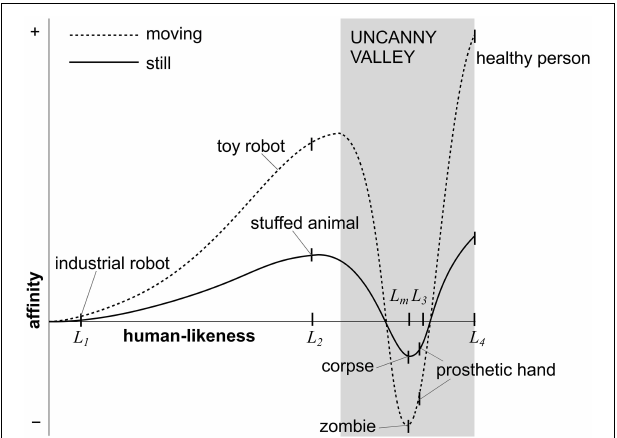
FIGURE 1 | Mori’s uncanny valley curve demonstrating the non-linear relationship between the human-likeness of stimuli (clearly artificial to fully human-like) and the observers’ sense of affinity for them (negative to positive). Human-likeness levels ( L 1 to L4 ) that correspond roughly with the turning points of the curves have been highlighted on the horizontal axis, and the uncanny valley proper has been emphasized with a dark gray color. Adapted with permission from MacDorman